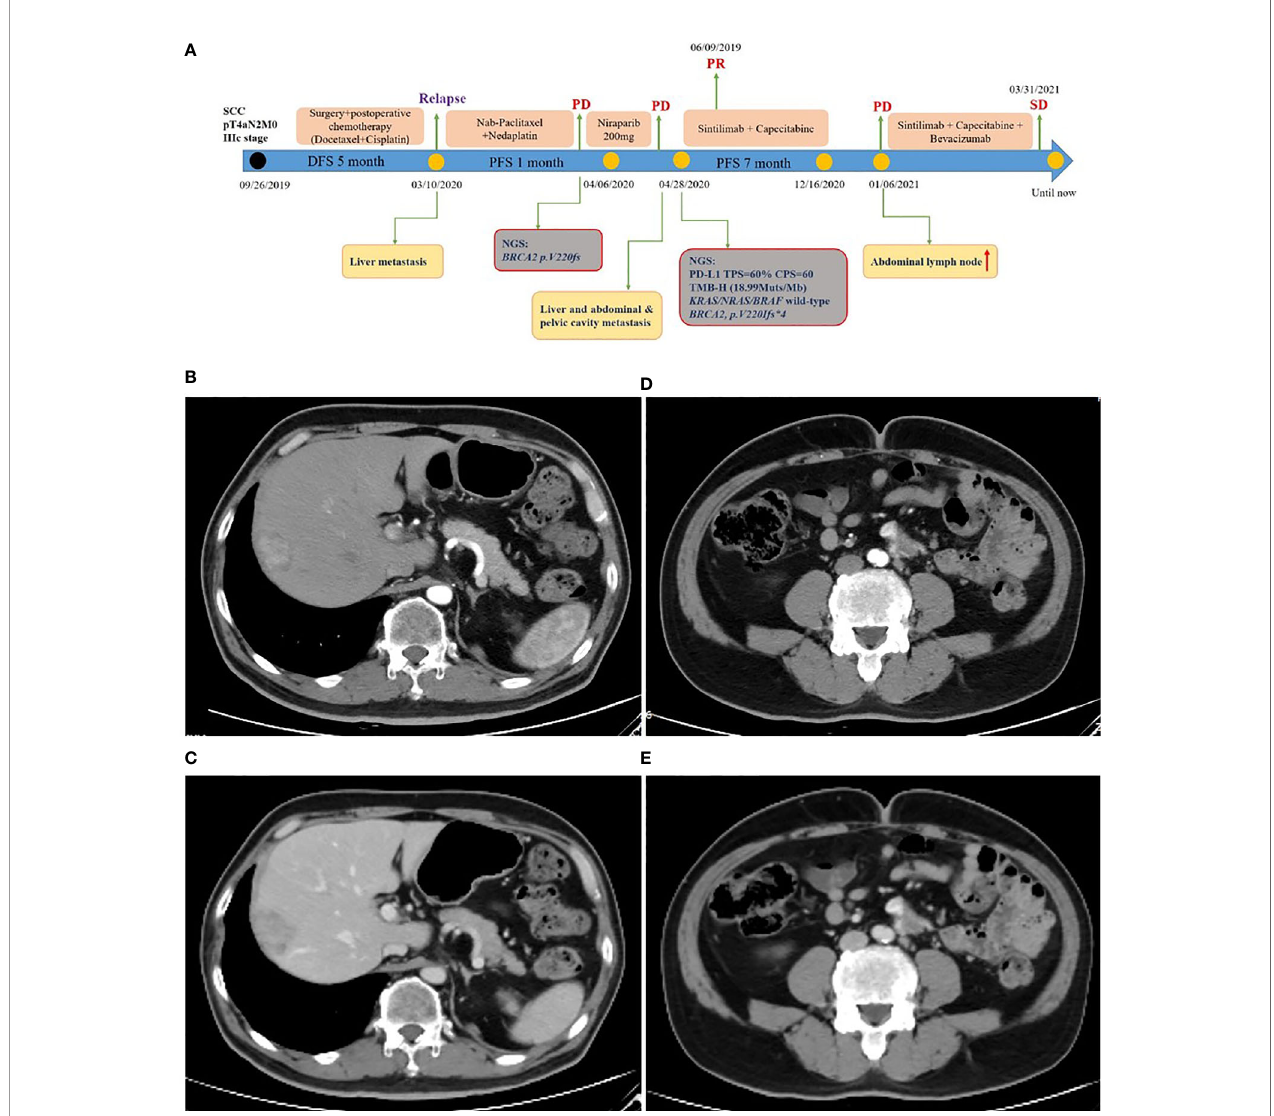
FIGURE 4 | Treatment of rectosigmoid-junction SCC cancer. (A) Timeline of the clinical course in this patient. (B, C) CT scan showed a partial response in liver metastasis (40 mm × 27 mm) from arterial and portal phase images. (D, E) CT scan showed a partial response in abdominal & pelvic cavity metastasis (32 mm × 18 mm) from arterial and portal phase